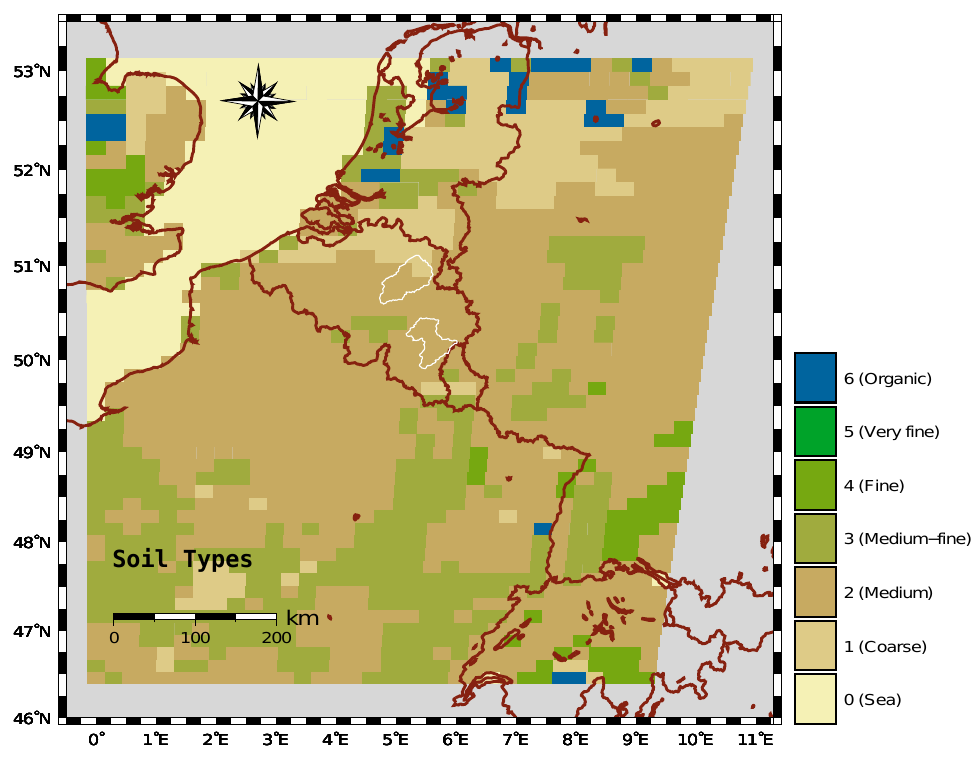
Figure 2. Soil types following